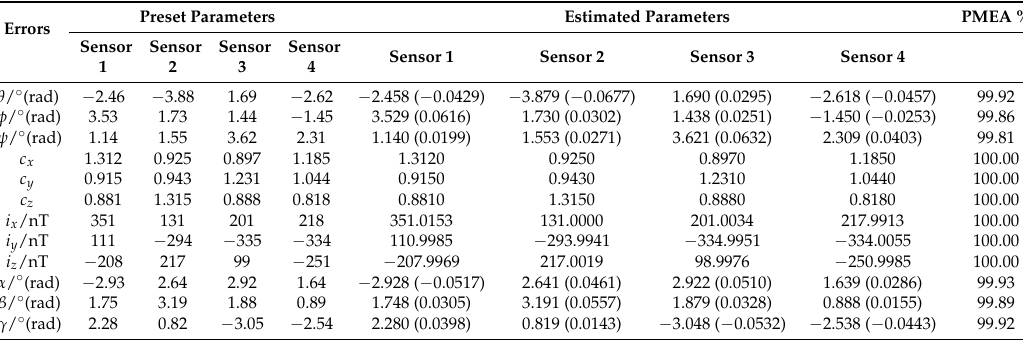
Table 3. Preset and estimated system error parameters in the